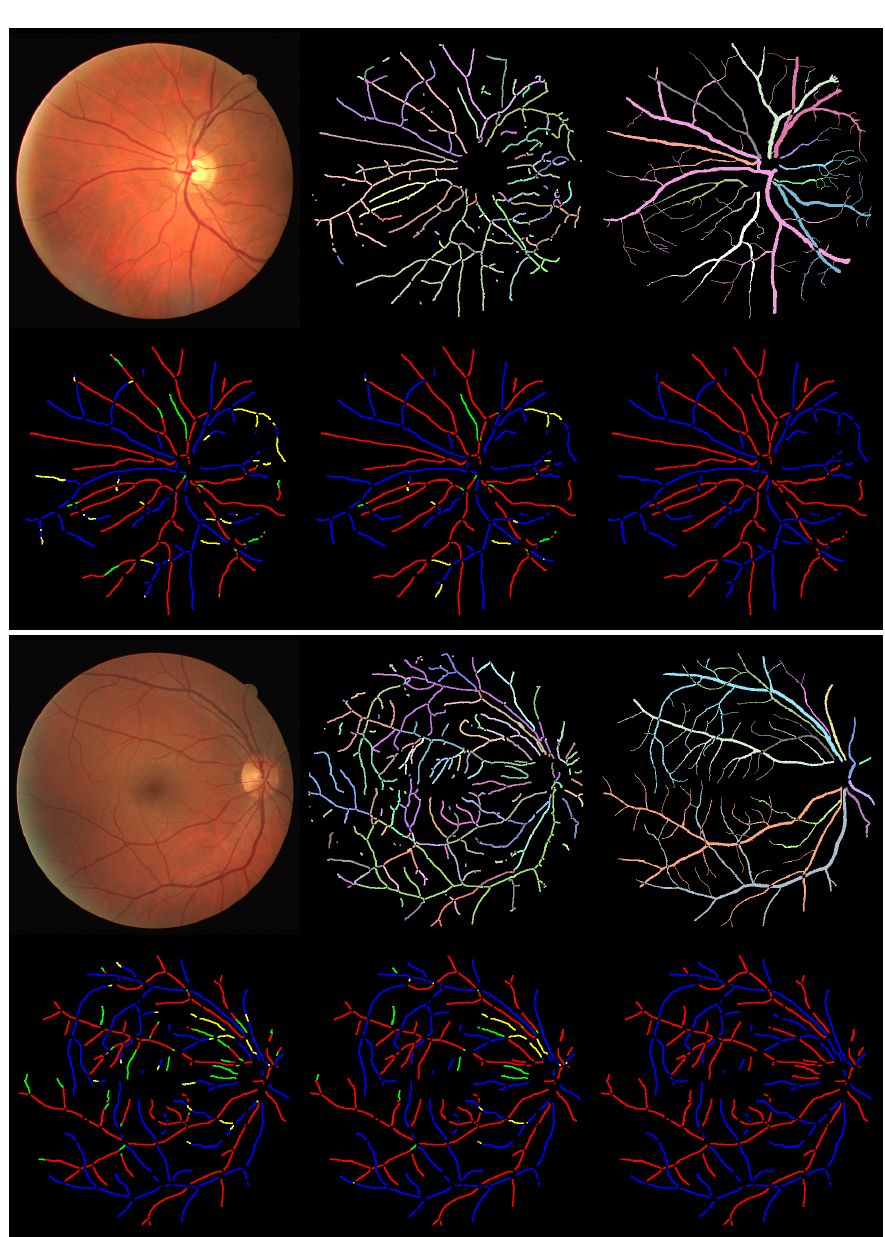
Figure 5. Two example results from the CT-DRIVE dataset. The six images for a single case are, in row-major order beginning from the top-left, the original input image, estimated topology of the proposed method, GT annotation of the topology, pixelwise AV classification result, tree-wise classification result of the proposed method, and AV GT annotation. Different colors in the topology GT represent separate trees. In each result, correctly classified arteries and veins are marked as red and blue, respectively. Centerlines incorrectly labeled as veins are in green, while those incorrectly labeled as arteries are in